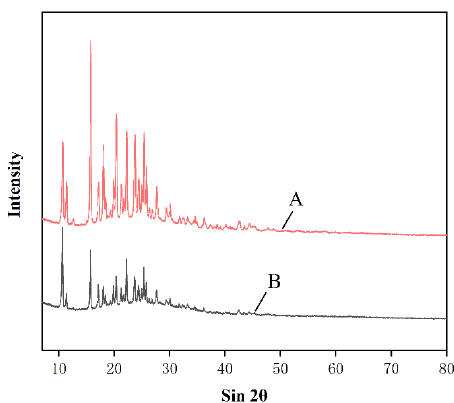
Figure 5. Comparison of raw naringenin ( A ) and NUP ( B ) under X-ray diffraction conditions.